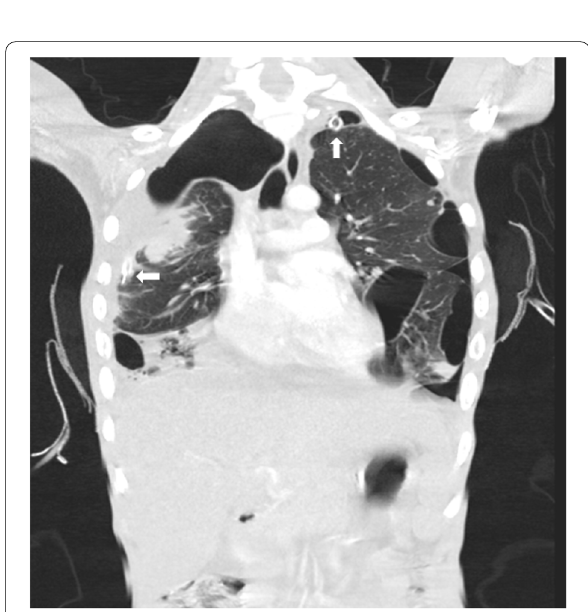
Fig. 5 Bilateral hydropneumothorax with multiple pulmonary metastatic nodules after bilateral ICD insertion